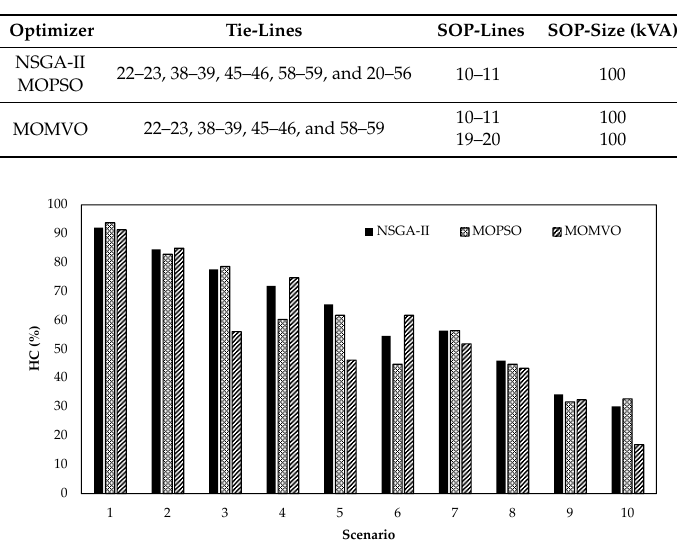
Figure 7. HC for each scenario: 59-node distribution system.